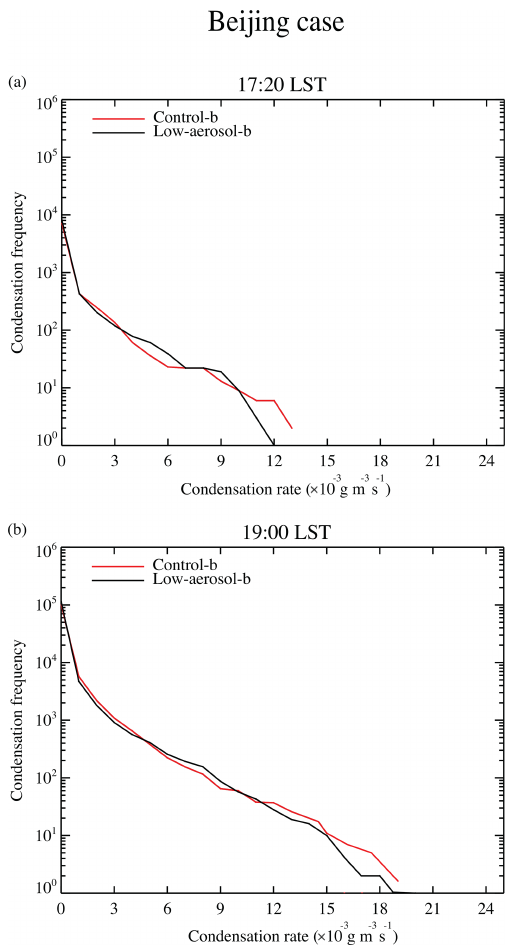
Figure 12. Cumulative frequency distributions of the column- averaged condensation rates in the control-b and low-aerosol-b runs for the Beijing case at (a) 17:20LST and (b) 19:00LST.